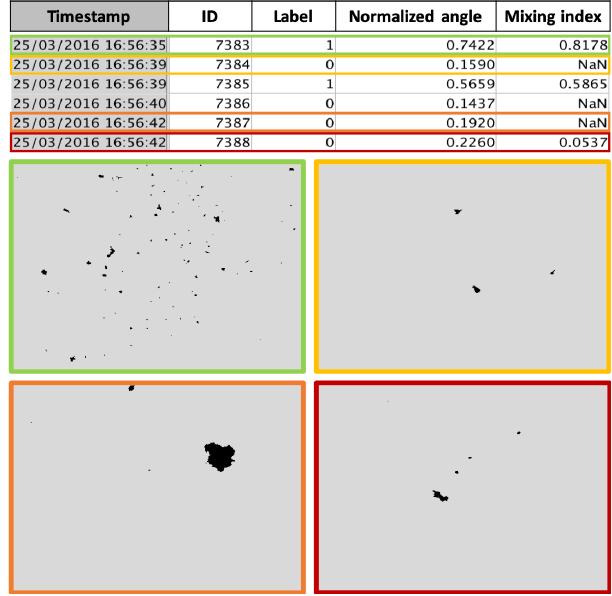
Figure 12. Consecutive MASC images from Davos and their re- spective classification label, normalized angle and mixing index. Label 1 is for blowing snow. A NaN mixing index means pure hy- drometeor (or pure blowing snow). A mixing index close to 1 (top- left image) means that it is near pure blowing snow, while a value close to 0 (bottom-right image) indicates proximity to pure precipi- tation.